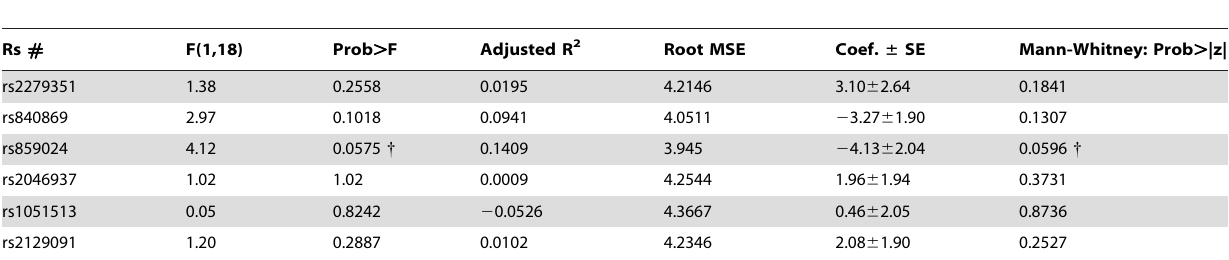
Table 4. Linear regression analysis and Mann-Whitney test for FGFR1OP2/wit3.0 SNP minor alleles and edentulous mandibular bone height